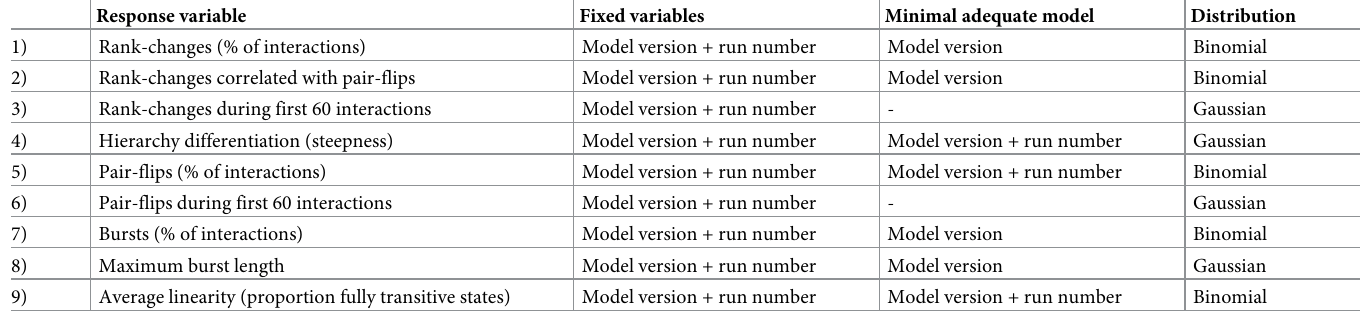
Table 1. Overview of the GLM models with their response variables, fixed variables in the full model, fixed variables after model reduction (minimal adequate model) and the distribution that was